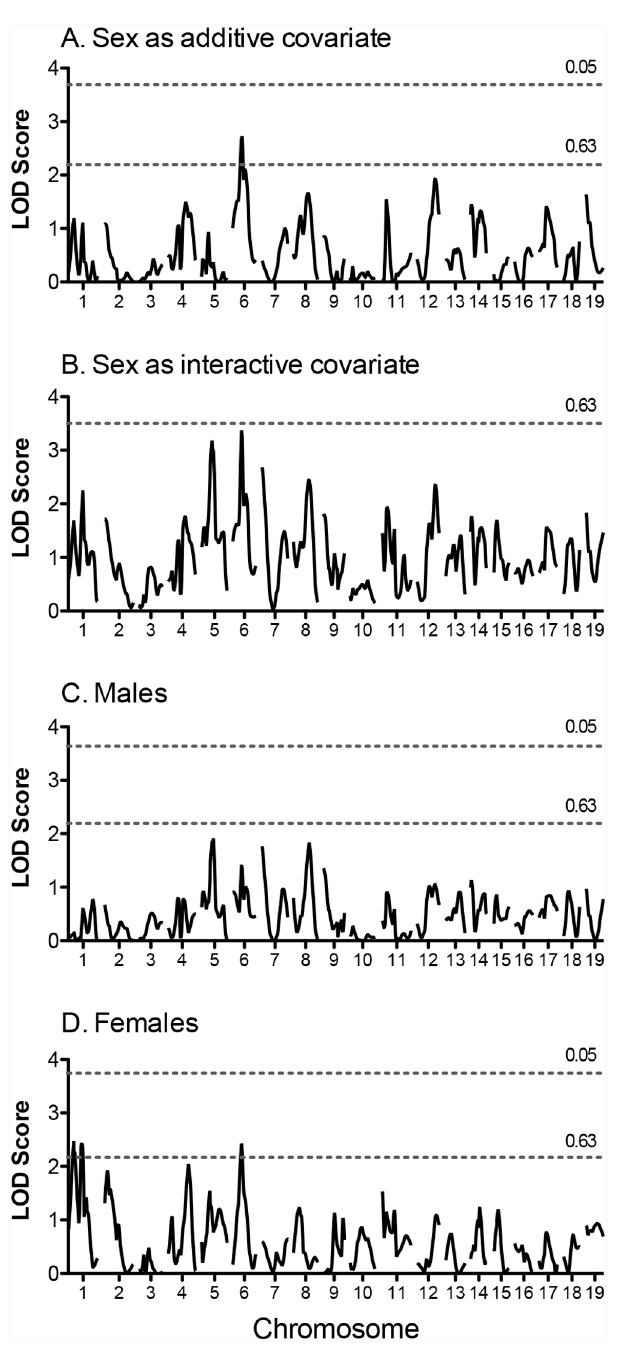
Fig 3. Genome-wide scan for the change exercise time in response to training in (NZW x 129S1) F 2 mice. Scans were performed for the entire population with “ sex ” as an additive covariate (A) or interactive covariate (B), and in males (C) and females (D) separately. Horizontal lines represent significant (P = 0.05) and suggestive (P = 0.63) logarithm of odds (LOD) thresholds, respectively. LOD thresholds were determined by permutation testing using 1000